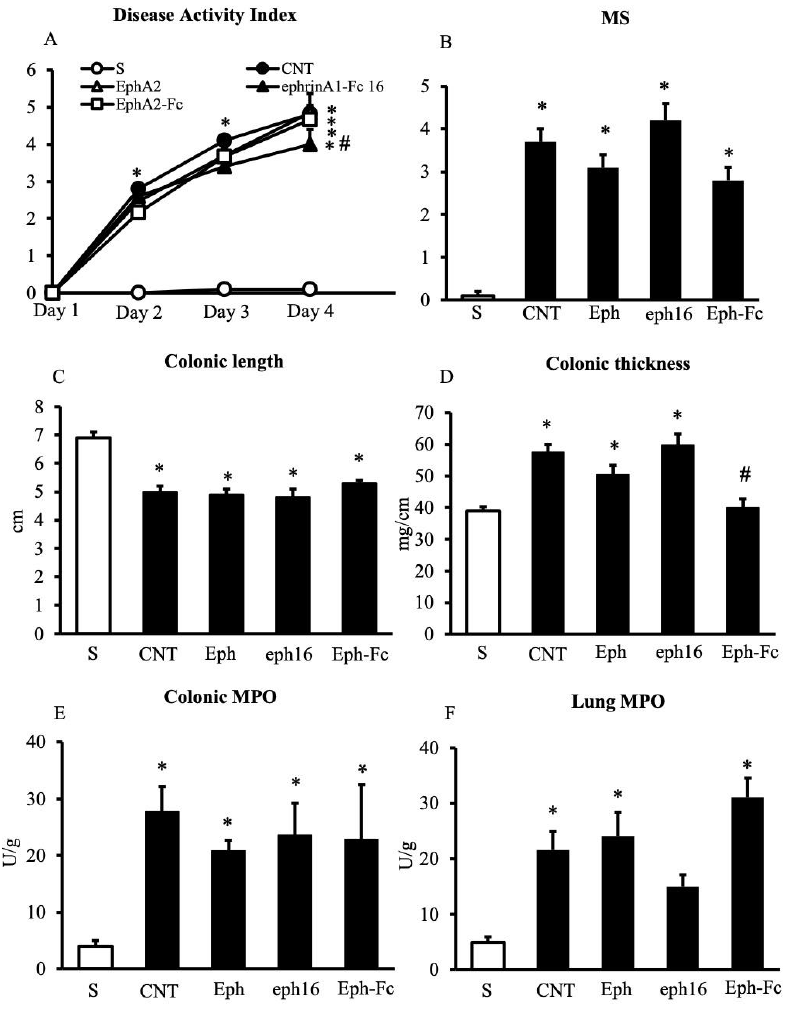
Figure 8. Effects of EphA/ephrin-A ligands on TNBS-induced inflammatory responses. Disease Activity Index ( A ), macroscopic score ( B ), colonic length ( C ), colonic thickness ( D ), colonic MPO ( E ) and lung MPO ( F ) activity assessed in vehicle-treated normal mice (S) and in TNBS-treated mice administered with vehicle (CNT), EphA2 20 mg/kg (Eph), ephrin-A1-Fc 16 mg/kg (eph16), and EphA2-Fc 30 mg/kg (Eph-Fc) ( n = 5–15 independent values per group). * p < 0.05 vs. S mice; # p <